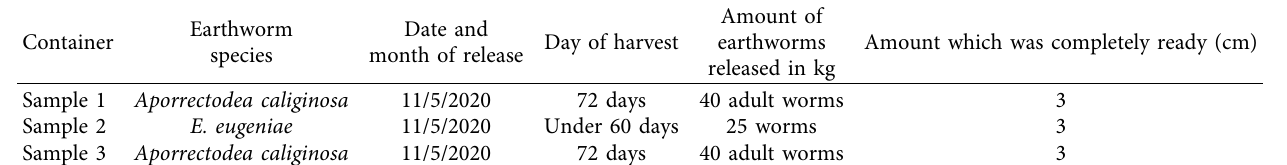
Table 3: Waste consumed by earthworms in different replicates.